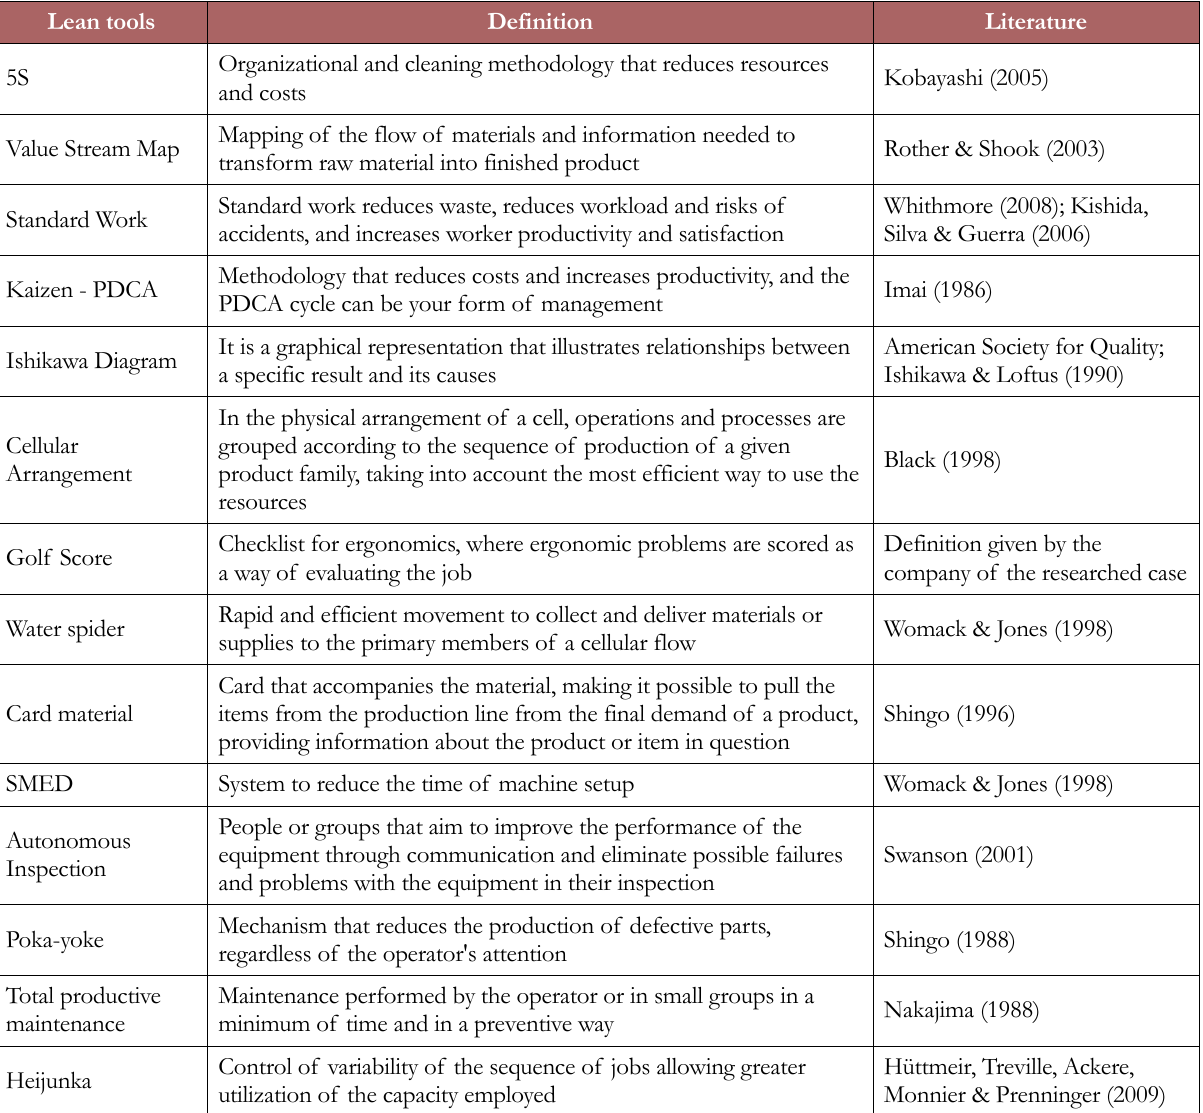
Table 2. Definition of Lean Manufacturing operational